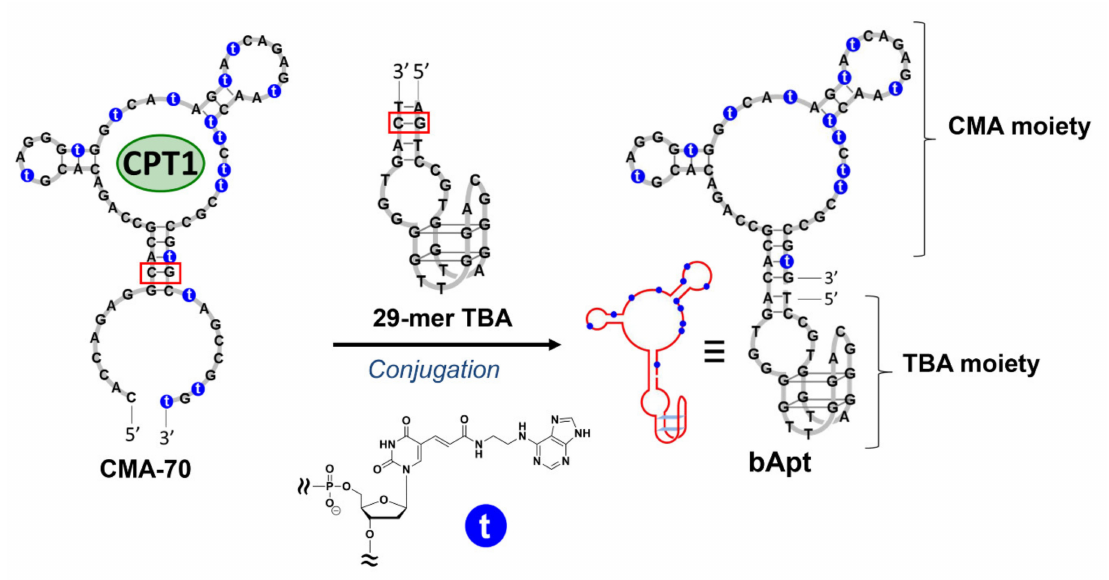
Figure 1. Design of bifunctional aptamer (bApt) conjugated with 29-mer thrombin-binding aptamer (TBA) and a camptothecin (CPT)-binding modified DNA aptamer (CMA-70) containing modified nucleic acids (2 (cid:48) -deoxyuridine-5 (cid:48) -phosphate (dU ad TP)) represented with (cid:48) t. (cid:48) Red boxes indicate the conjugation